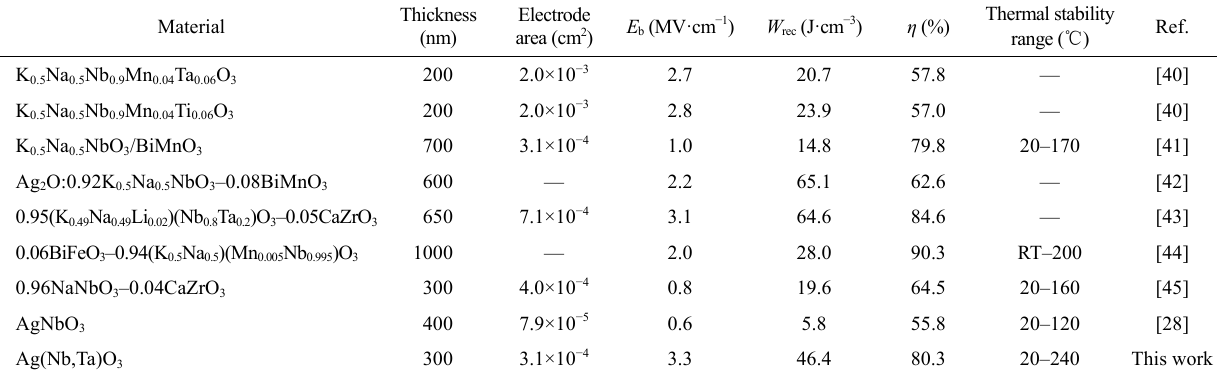
Fig. 7 Temperature-dependent (a) P–E loops and (b) their associated W rec and ŋ performances of ANT 700-RTA film. Table 1 Energy storage properties and thermal stabilities of representative niobate-based films for energy storage